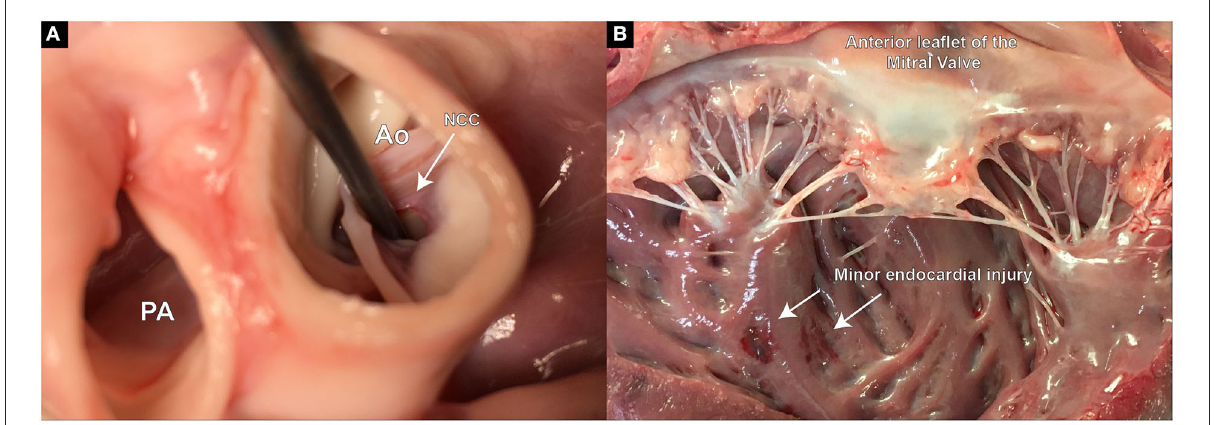
FIGURE5 Postmortem examination of defect size, location, and potential extra-valvular injuries created during the procedure. (A) Demonstrates the defect precisely placed at the hinge point of the aortic leaflet in the RCC region; (B) Slight injury on the endocardial surface of the left ventricle, most likely caused during the insertion of the piercing guide wire.